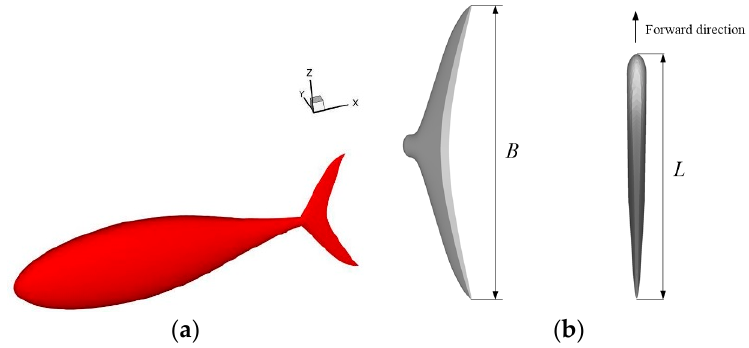
Figure 1. Three-dimensional geometric model: ( a ) thunniform bio-inspired mode; ( b ) crescent-shaped foil.